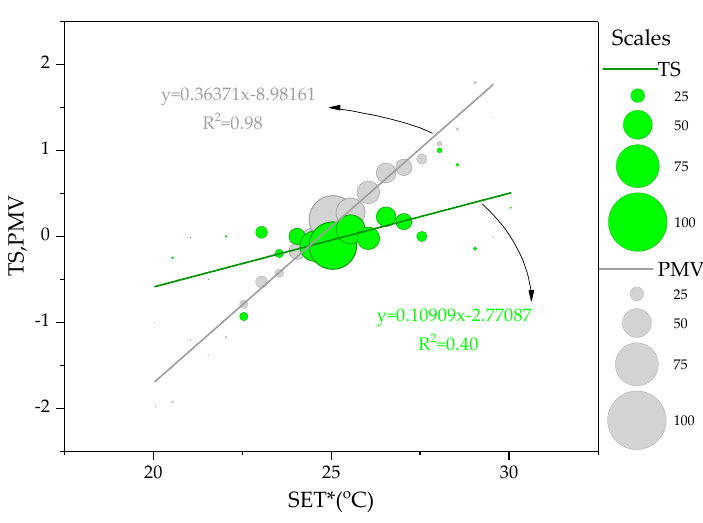
Figure 6. Comparison between TS and PMV against SET*.